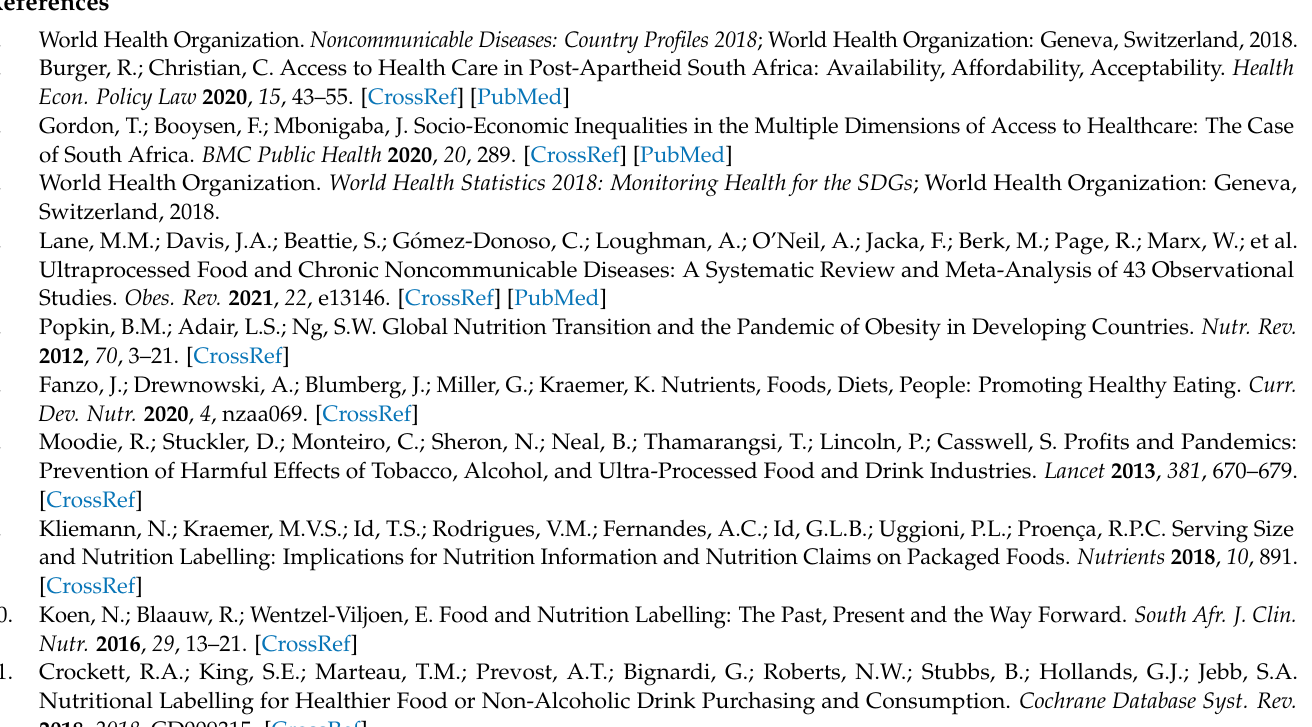
Table S3. Label improvement themes from qualitative interviews; Table S4. Challenges related to food labeling as identified by interview participants; Table S5. Cronbach alpha for HCS; Table S6. Cronbach alpha for FOP label